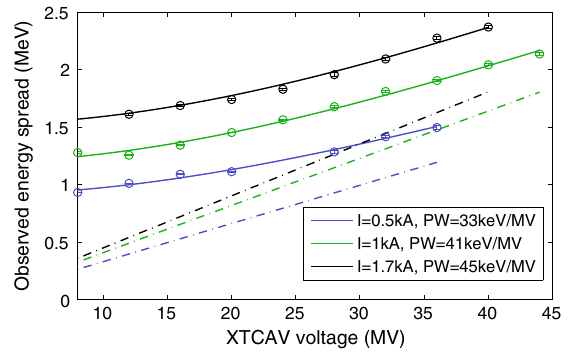
FIG. 16. Measured slice energy spread as a function of XTCAV voltage. The solid line is a fit of the form given in Eq. (E2), and the dotted line shows the contribution to the fit from the XTCAV ( 33 – 45 keV = MV, with 2 – 4% fit uncertainty). The stronger PW effect at higher currents is due to larger beam size, either from a worse match or larger slice emittance. Data taken with 22 keV energy spread induced by the laser heater.